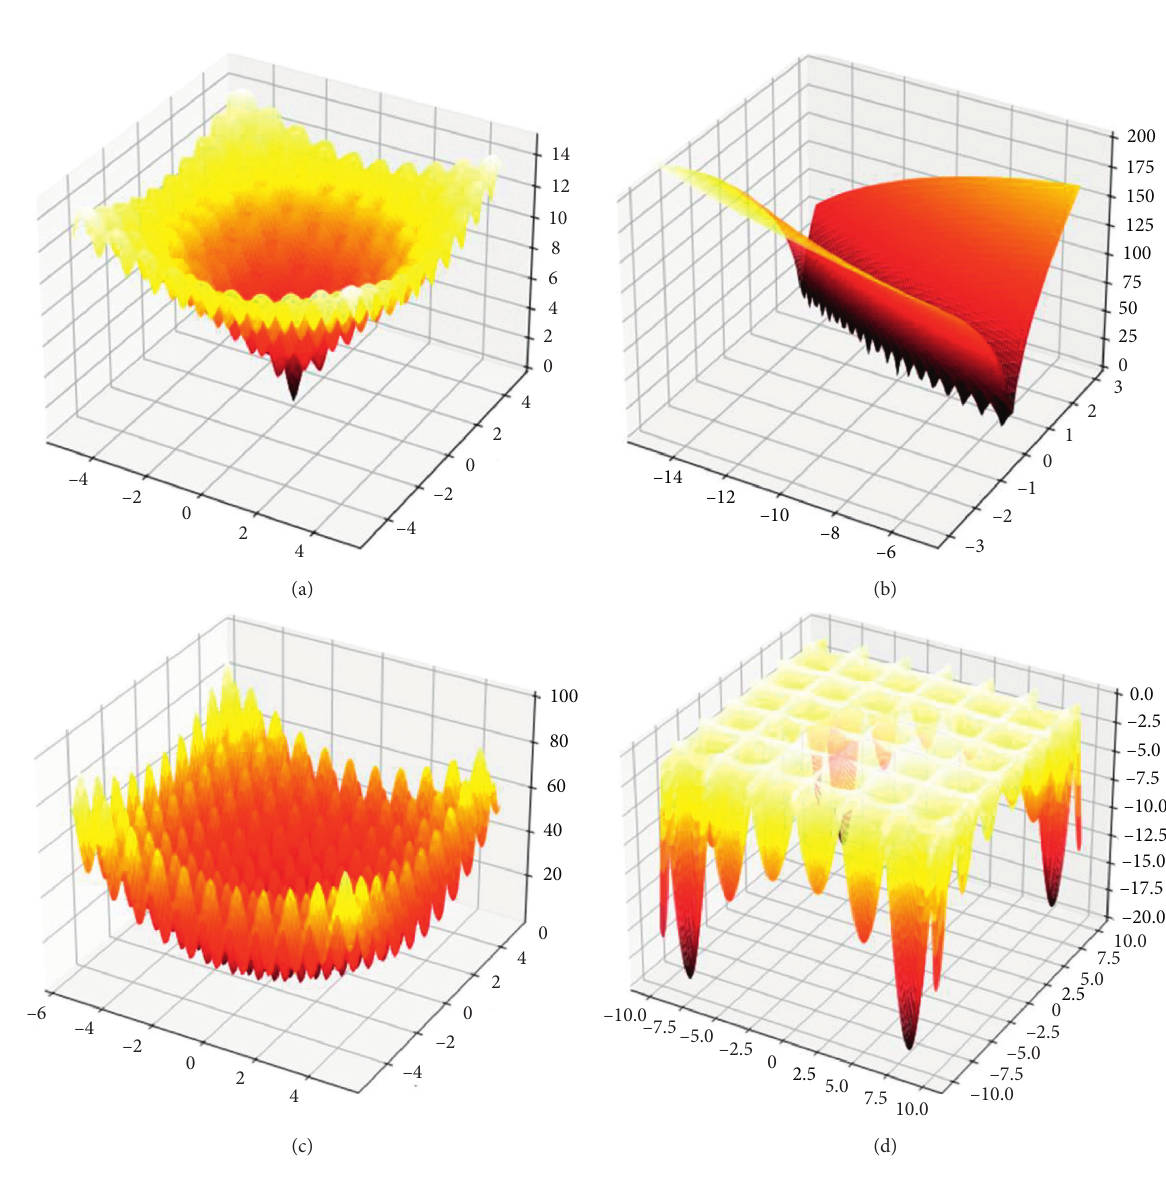
Figure 1: f 1– f 4 functions’ schematic